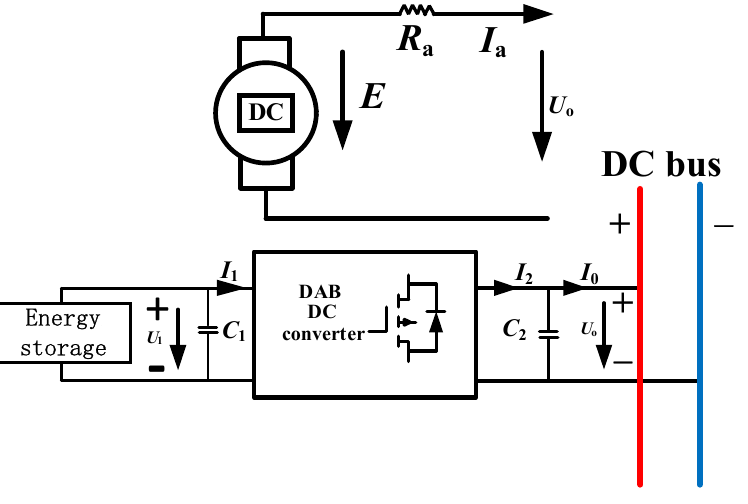
Figure 3. VDCM Figure 3. VDCM model.